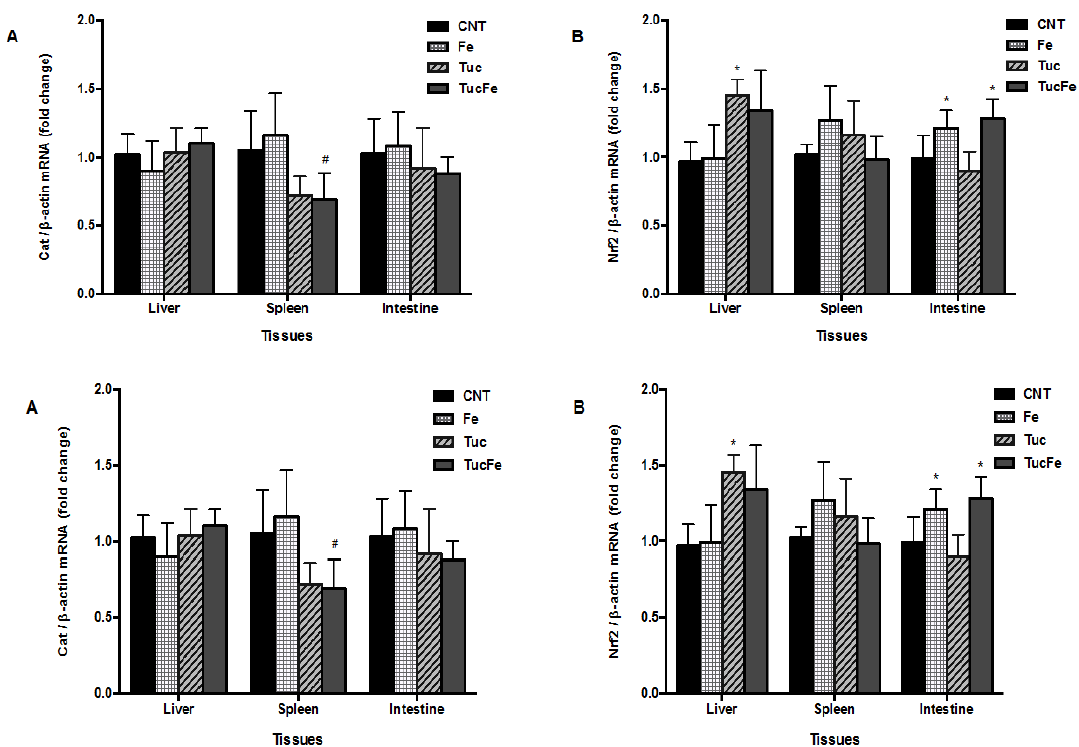
Figure 4. Quantification of mRNA levels of nuclear factor erythroid 2-related factor 2 (Nrf2) and catalase (Cat) in the liver, spleen and intestine and heme oxygenase-1 (Hmox1) and NAD(P)H dehydrogenase quinone 1 (Nqo1) in the liver, determined by qPCR. CNT, Control group; Fe, iron-enriched group, Tuc, tucum-do-cerrado group; TucFe, tucum-do-cerrado iron-enriched group. Data are the means ± SD ( n = 6). Significant differences ( p < 0.05): * Comparison to the Control group; # Comparison to the Fe group.